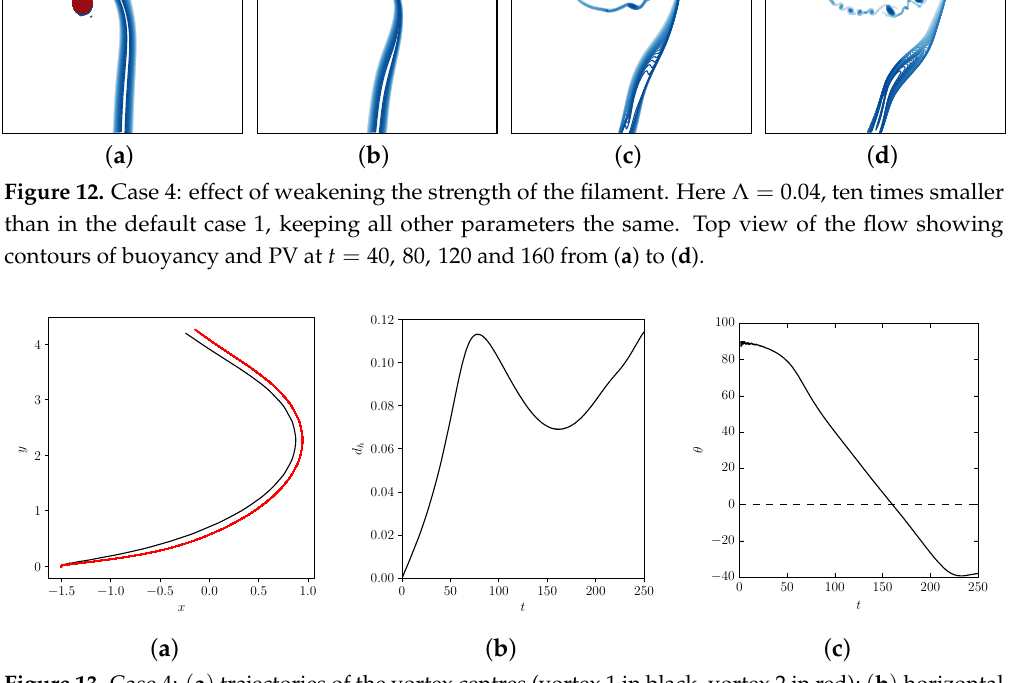
Figure 13. Case 4: ( a ) trajectories of the vortex centres (vortex 1 in black, vortex 2 in red); ( b ) horizontal distance between the vortex centres d h versus time t ; and ( c ) angle between the axis joining the vortices centres and the x